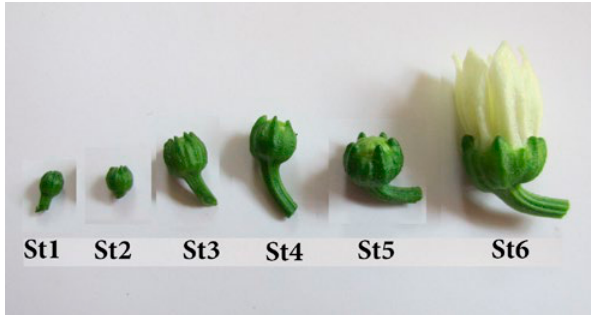
Figure 1. Flower bud sizes: Stage 1: 1-2 mm diameter (St1). Stage 2: 3-4 mm diameter (St2). Stage 3: 3-5 mm diameter (St3). Stage 4: 9-10 mm diameter (St4). Stage 5: 10-15 mm diameter (St5). Stage 6: 20 mm diameter